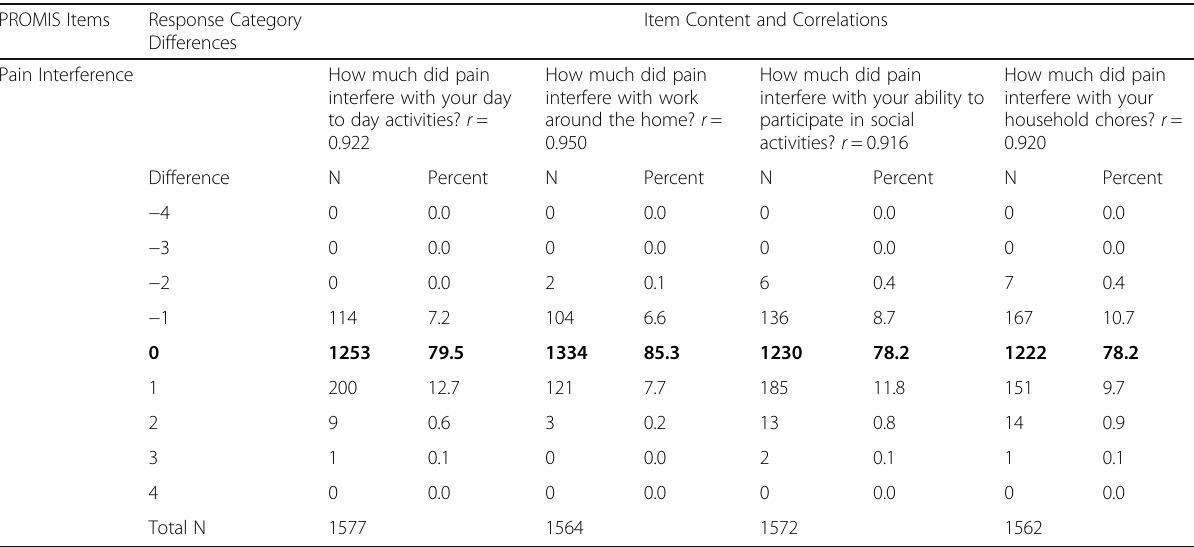
Table 2 Differences scores (observed - predicted response category) and Spearman correlations between observed and